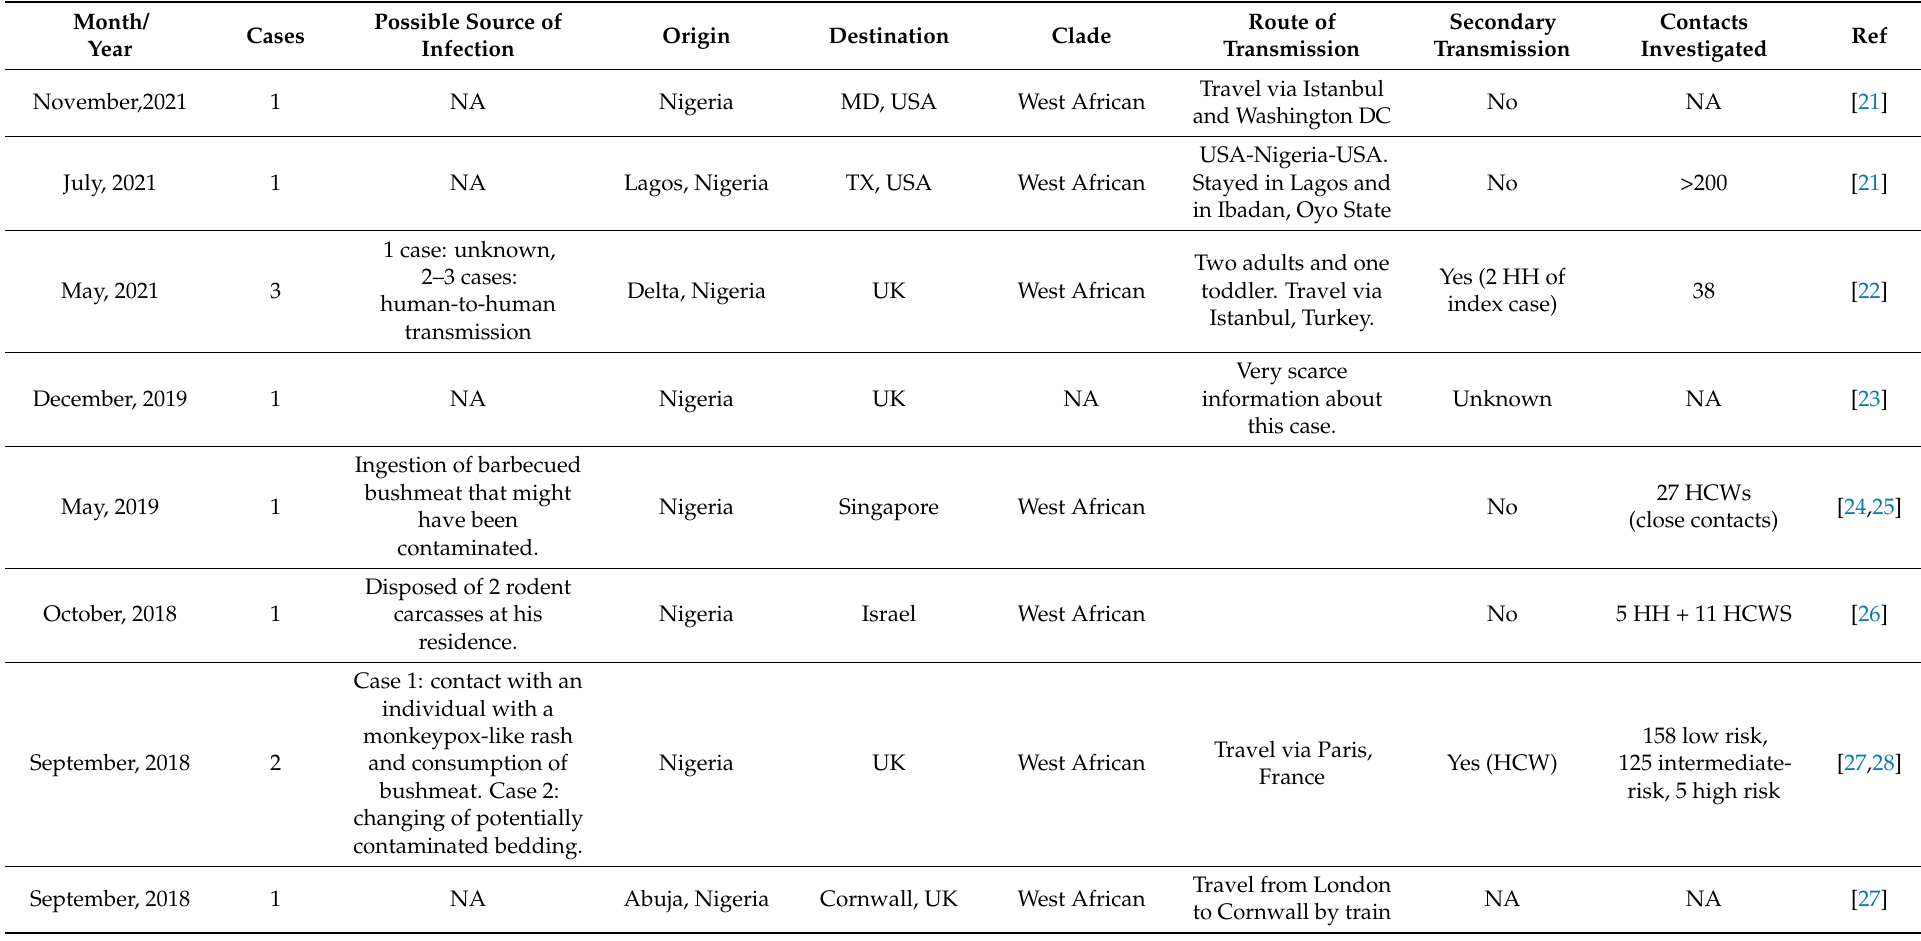
Table 2. Laboratory-confirmed cases of human monkeypox outside of Africa (2018–2021). NA = Not